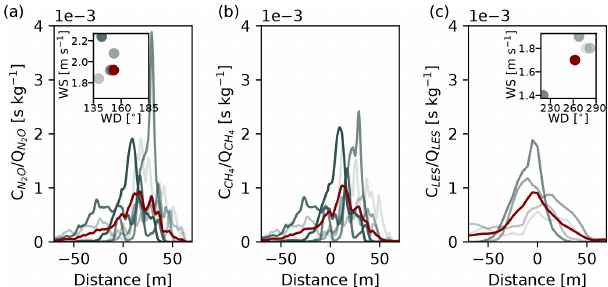
Figure 7. Averages of instantaneous plumes over half-hour periods from (a) N 2 O, (b) CH 4 and (c) LES. All plumes have been scaled = = 0 . 59, Q with their respective emission rates, i.e., Q N CH 4 2 O 1 . 23 and Q LES = 1gs − 1 . LES transects were taken at 3m height and 78m downwind from the source. Plumes are shown with a color gradient corresponding to the half-hour increments i.e., lightest gray plume is the average of plumes measured over the time period 11:30–12:00UTC; dark gray is the average over 14:00–14:30UTC. The inset shows horizontal wind speed and direction for the cor- responding half-hour averages in (a) measurements and (c) LES. Overlaid in red is the average of all the plumes, as well as the aver- ages of horizontal wind speed and direction in the